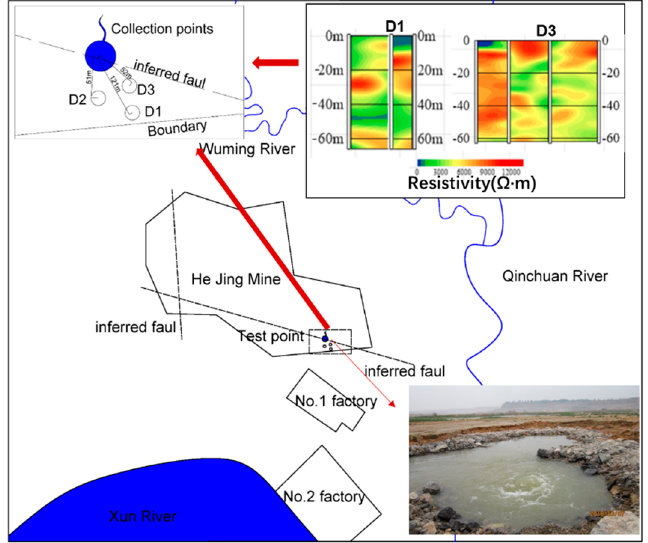
Figure 5. Mine area distribution.